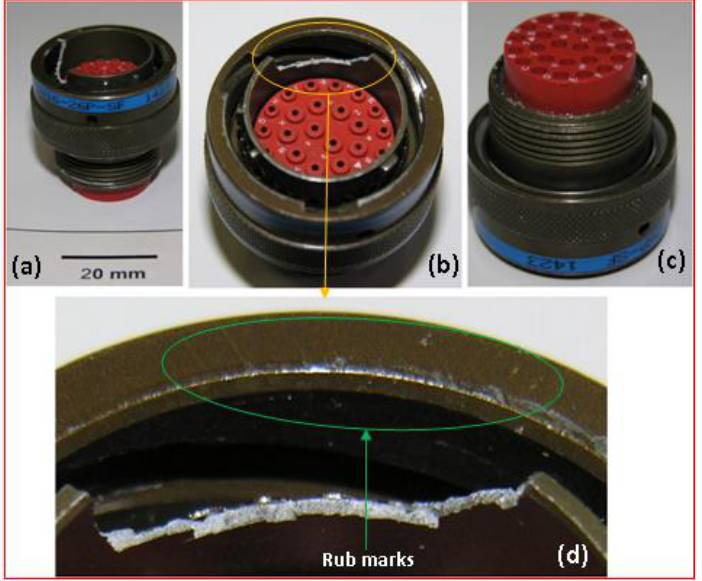
Figure 4: Photographs of the as-received connector 1 in different